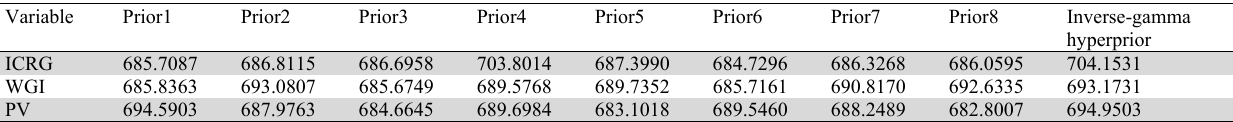
Prior selection